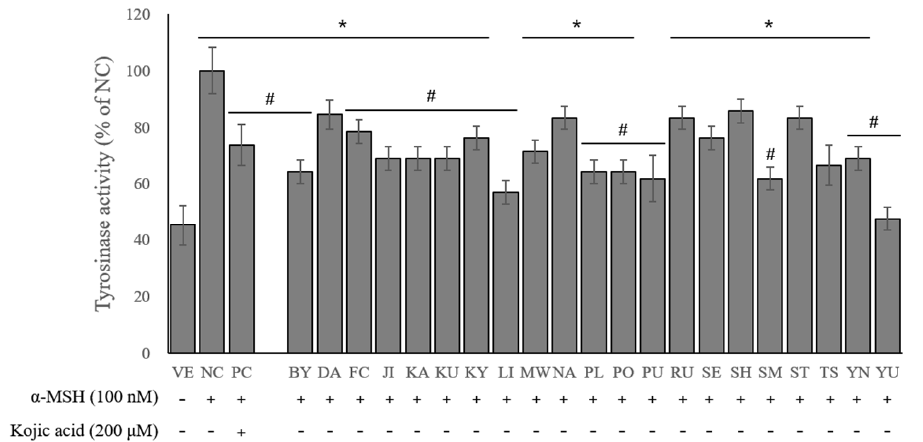
Figure 3. Effects of essential oils on tyrosinase activity. Values are presented as means ± standard deviations. Note: * p < 0.05 compared to VE; # p < 0.05 compared to NC. VE, vehicle group; NC, 100